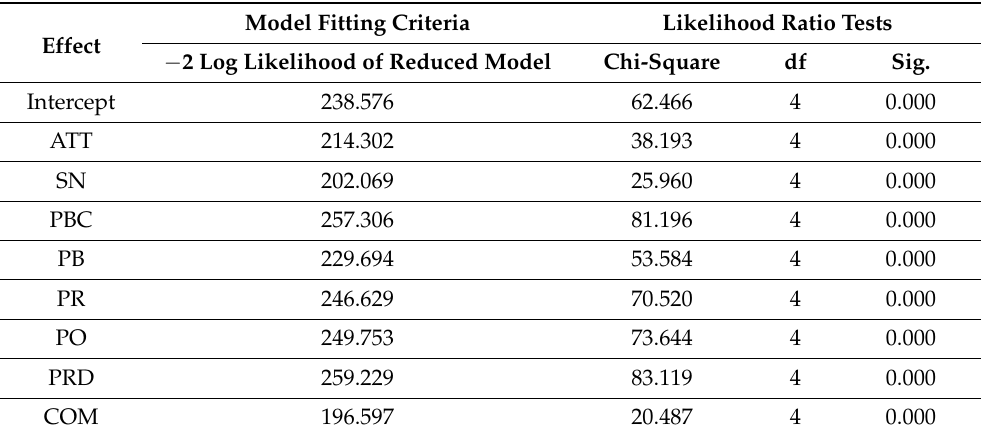
Table 4. The likelihood ratio